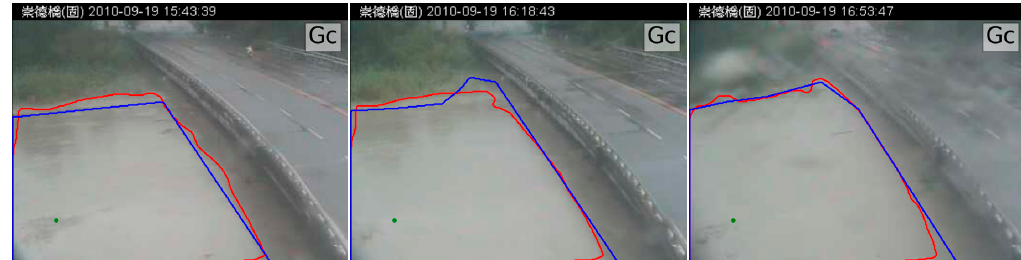
Figure 16. Hybrid RgGc results with red segments from growing methods. The blue line is the ground truth, and the green marker is the initial seed for the growing methods. This figure only shows Images 0, 35, 70, 105, 140, 175, 210, 245, and 280 from the image set, in order to clearly show the contours and seeded marker. The text in the upper-right corner distinguishes between images processed with RegGro (Rg) and GrowCut (Gc). (Note: The Traditional Chinese in header of all images is represented the location in the Changed Bridge except).